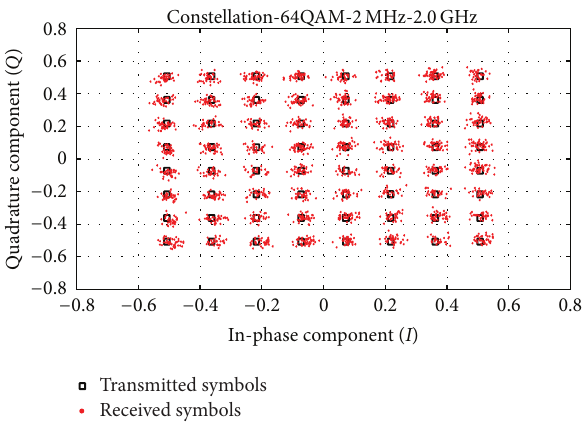
Figure 6: Transmitted and received constellation points of a 64- QAM signal having 2 MHz bandwidth for low-IF receiver.